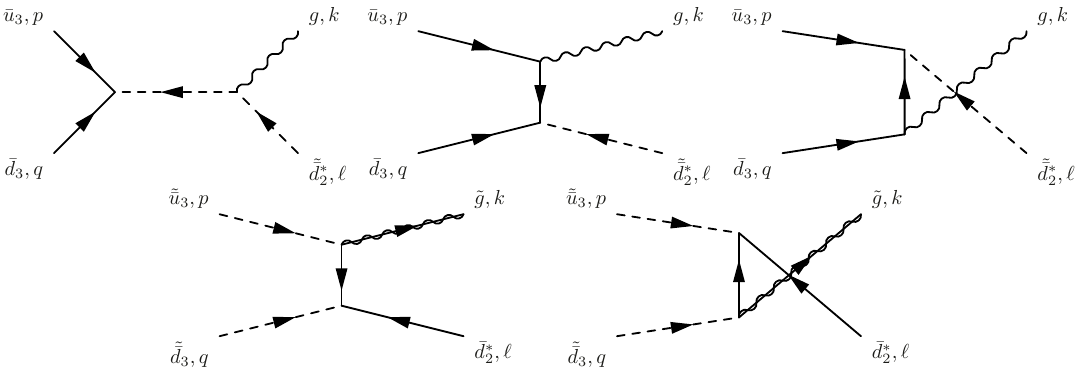
Figure 4 . B − L violating scattering from a dimensionless RPV